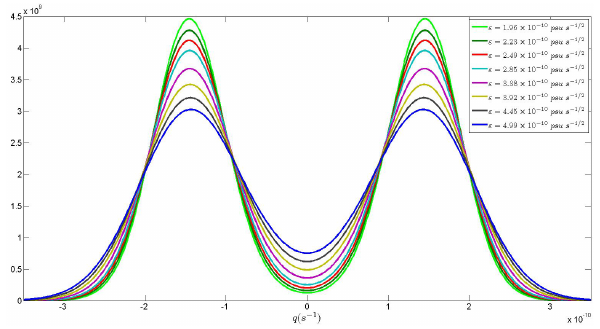
Fig. 7. Empirical probability distribution function for the THC strength in the full model for some selected values of symmetrically applied